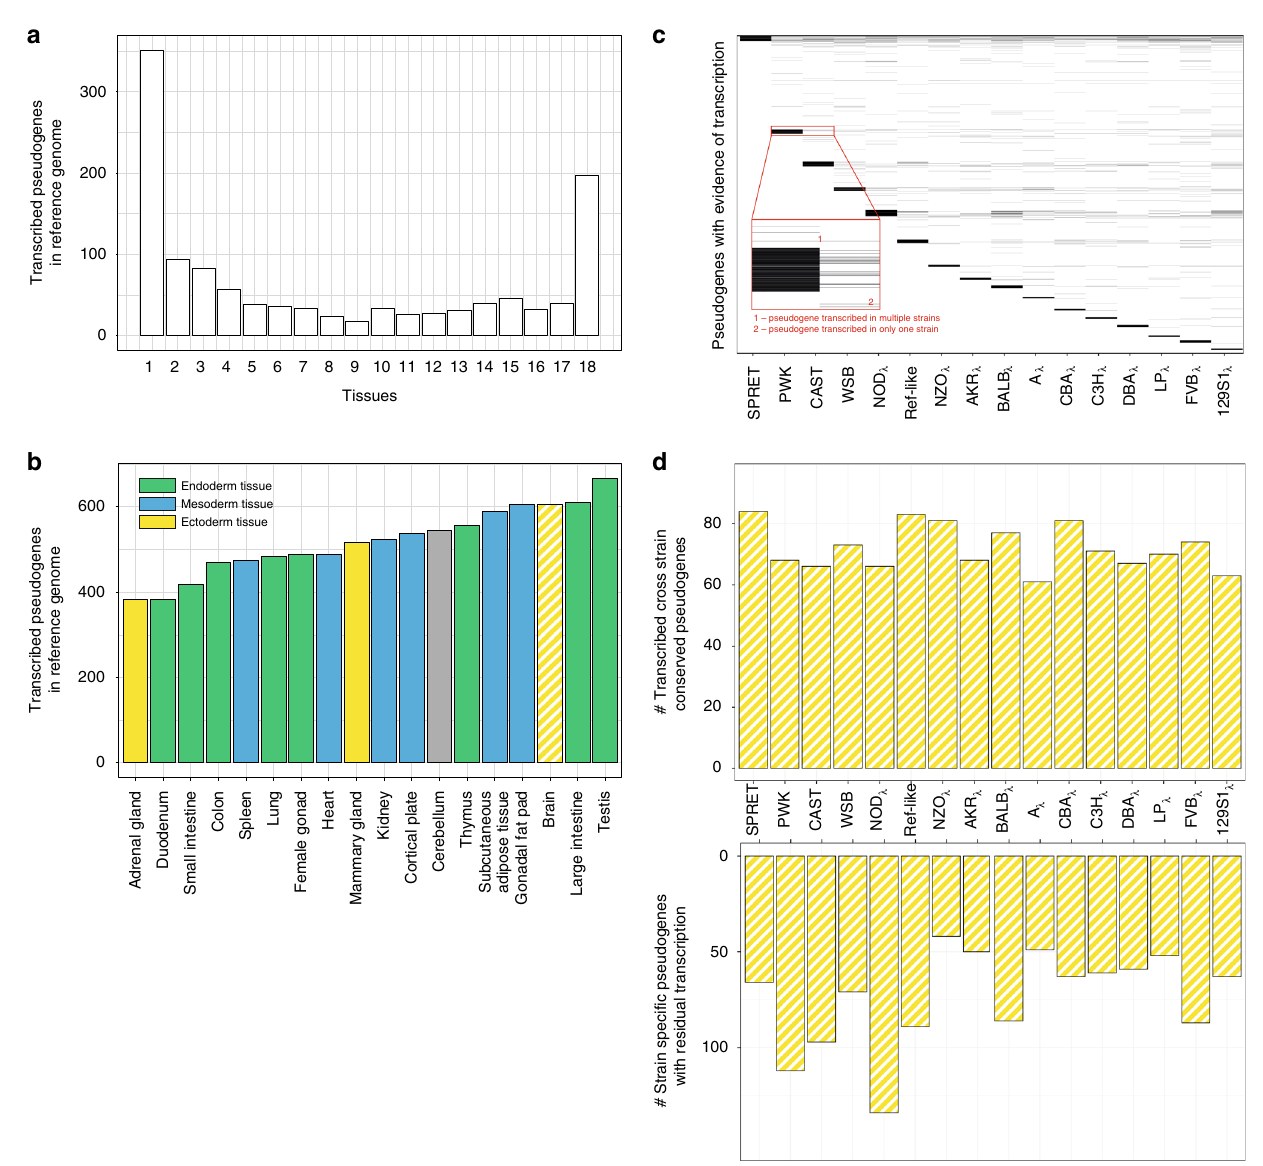
Fig. 7 Pseudogene transcription and activity. a Cross-tissue pseudogene transcription in the mouse reference genome. The x-axis indicates the number of tissues in which a pseudogene is transcribed. b Distribution of pseudogene transcription in 18 adult mouse tissues. All data of the transcribed mouse reference genome pseudogenes in the 18 tissues is available in Supplementary Data 6. c Heatmap-like plot showing the distribution of transcribed pseudogenes ( y -axis) in brain tissue for each wild-derived and classical laboratory mouse strain ( x -axis). Each line corresponds to a transcribed pseudogene with an expression level higher than 2 (FPKM). When a line is present across multiple columns, it is indicative of a pseudogene expressed in all these strains. The dark bars at the top of each strain column are formed by multiple highly expressed pseudogenes. When a line is present in only one strain, and no other line is observed at the same level in any of the other strains, this suggests that the pseudogene expression is strain speci fi c. d (top) Number of transcribed pseudogenes that are conserved across all the strains. d (bottom) Number of transcribed strain-speci fi c pseudogenes in each mouse strain. Data recording the transcribed pseudogenes in brain for each strain is available from Supplementary Data